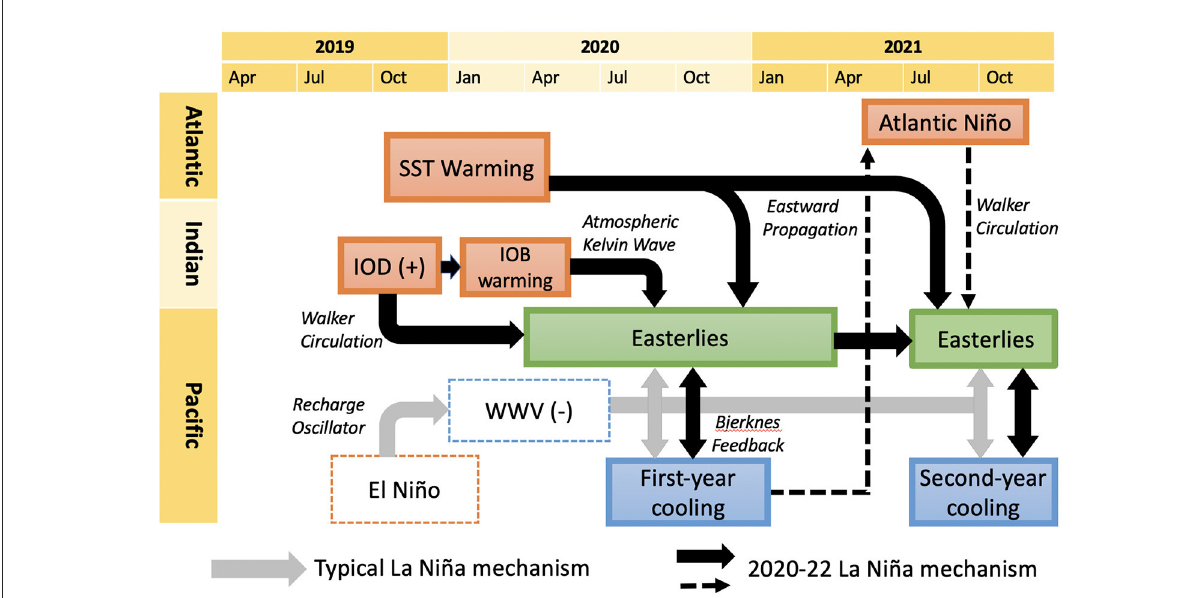
FIGURE6 Schematic representation of the energizing and persistent processes of 2020–2022 La Niña in comparison to typical double-dip La Niña events. Solid grey arrow represents typical La Niña mechanism whereas the solid and dashed black arrow represent 2020–2022 La Niña